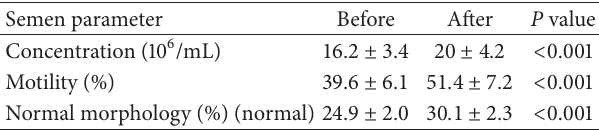
Normal morphology (%) (normal) 24.9 ± 2.0 30.1 ± 2.3 < 0.001 Data are mean ± standard